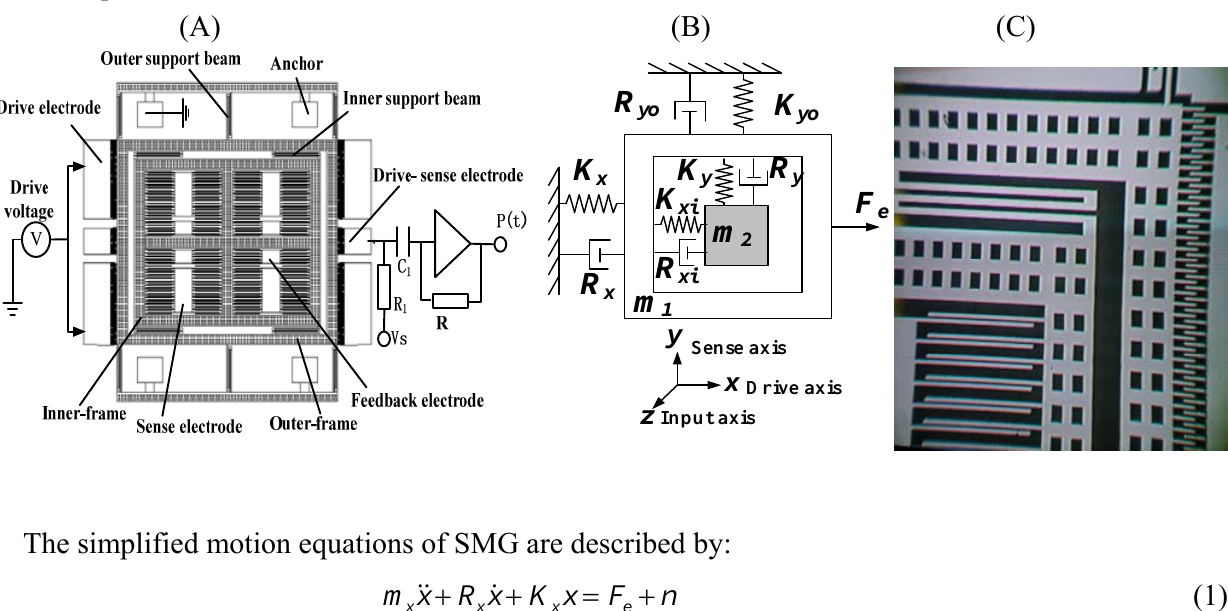
Figure 1. (A) The frame of the SMG. (B) The simple model of SMG. (C) The picture of the processed